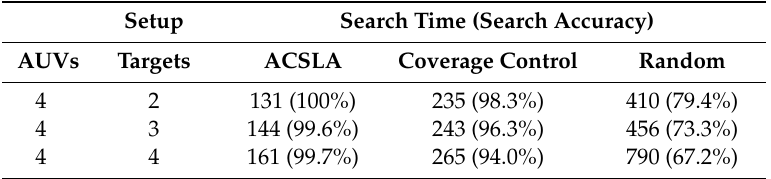
Table 1. Comparative